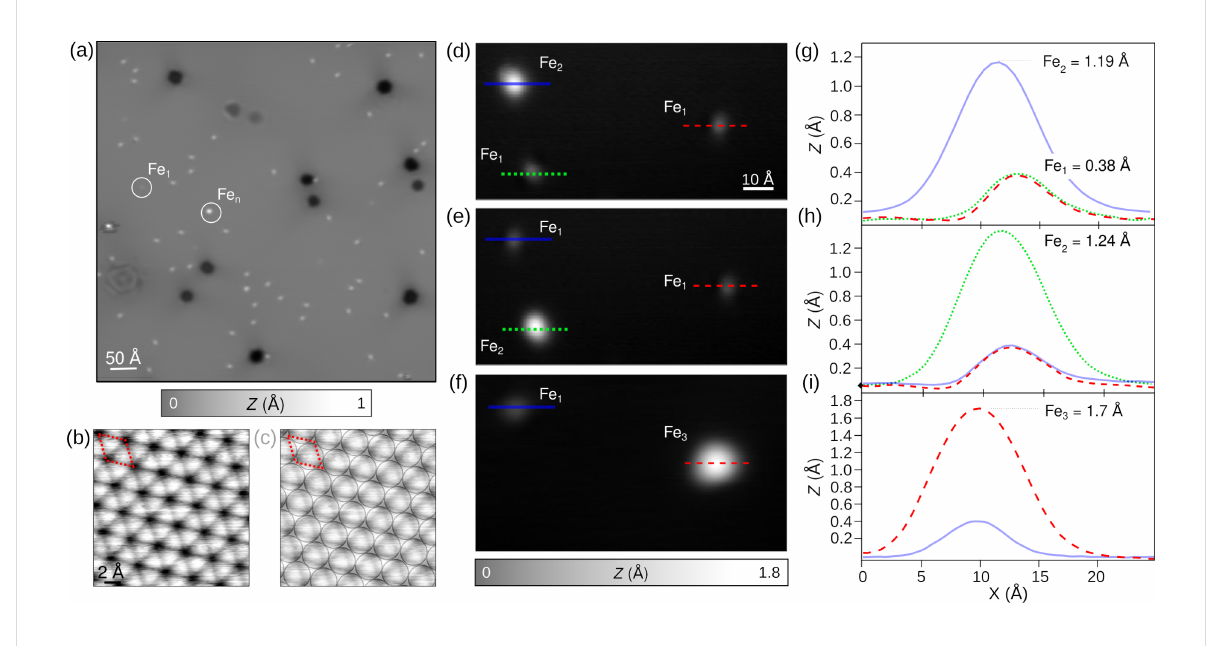
Figure 4: Fe adatoms on Pb(111) and their lateral manipulations. (a) STM overview image of Pb(111) after deposition of Fe adatoms ( V t = − 700 mV, I t = 5 pA). Fe 1 and Fe n correspond to a single Fe adatom and clusters of n adatoms, respectively, ( V t = − 15 mV, I t = 5 pA). (b) Topographic STM image during the manipulation of a single Fe atom trapped in the STM junction. (c) Models of the Pb(111) corresponding to the STM image of panel (b). The red dashed parallelogram refers to the Pb(111) lattice. (d–f) Series of STM images of Fe adatoms and their successive lateral manipulations with the STM tip. In panel (f), the STM image shows the formation of a Fe trimer Fe 3 by successive tip manipulations (imaging conditions, V t = − 30 mV, I t = 60 pA). (g–i) Apparent STM heights extracted from panels (d–f) enabling one to distinguish from their topographic signatures Fe 1 , Fe 2 and Fe 3 ,